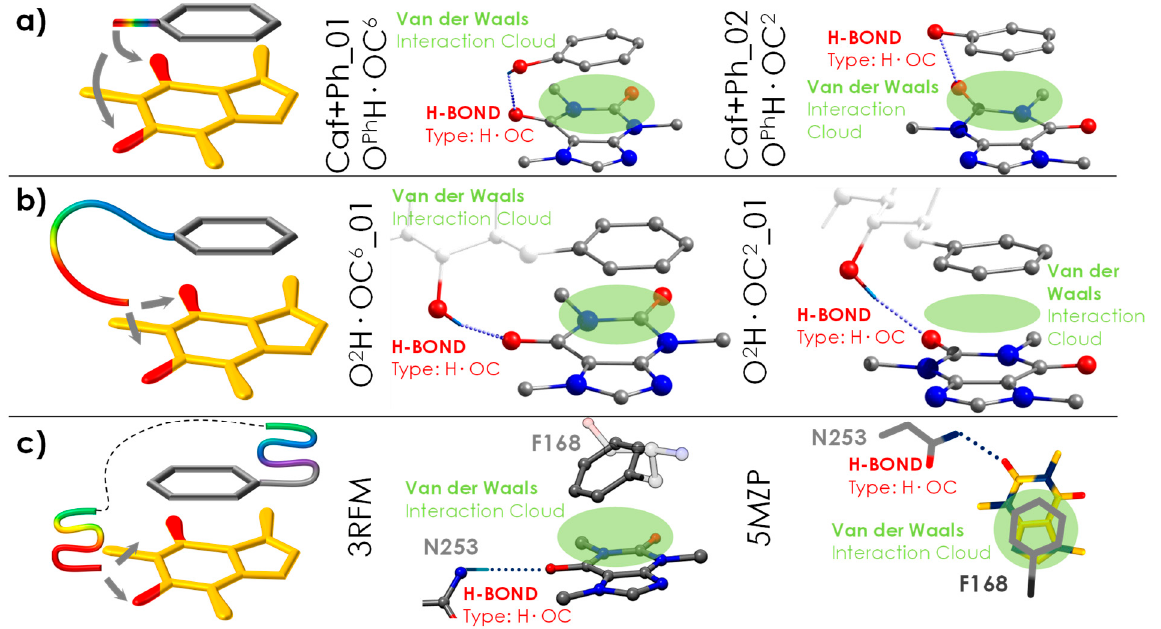
Figure 6. ( a ) The most strongly bonded conformations of Caf+Ph (Caf+Ph_01 and Caf+Ph_02) [15]. ( b ) The most strongly bonded conformations of Caf+PhGlc (O 2 H·OC 2 _01 and O 2 H·OC 6 _01). ( c ) The comparison of the structures is extended to the A 2A receptor. The PDB codes of the corresponding structures are 3RFM [8] and 5MZP [9].